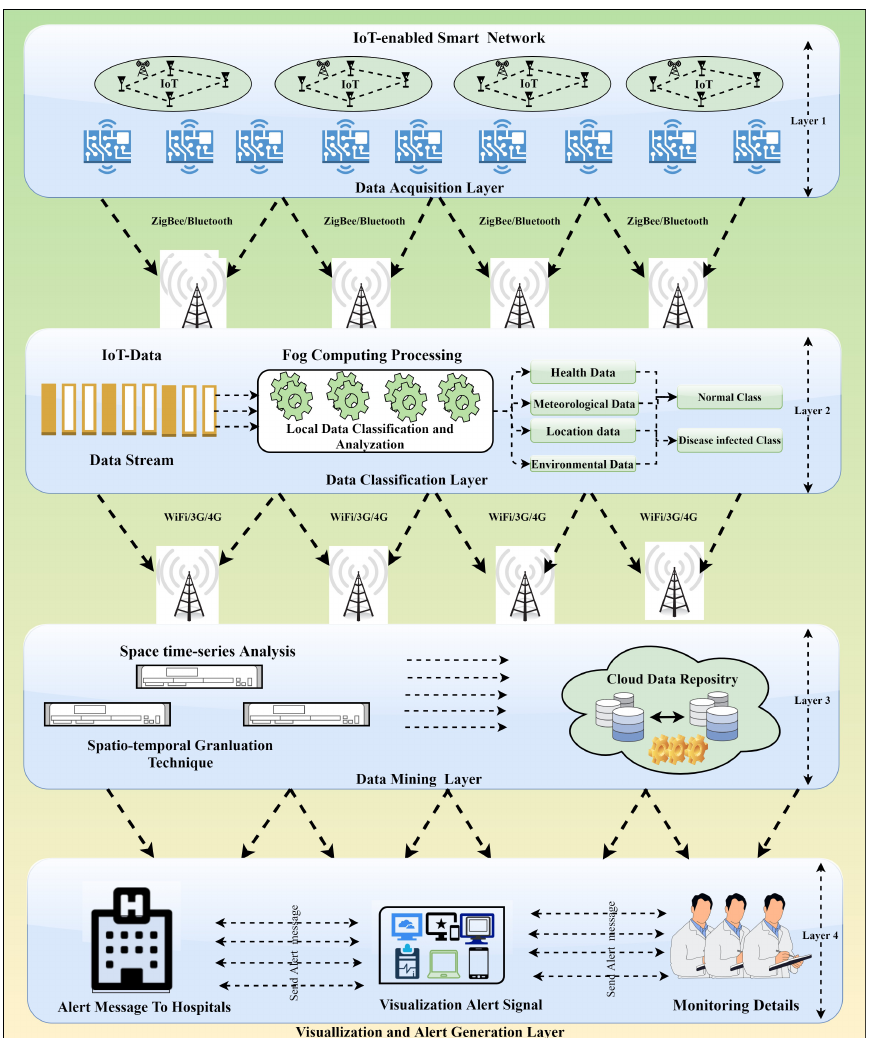
Figure 4. Layered architecture of proposed